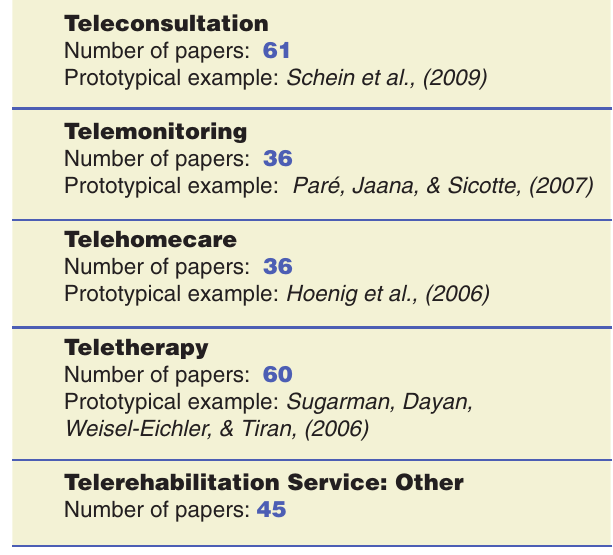
Table 1. TR Services in the Past